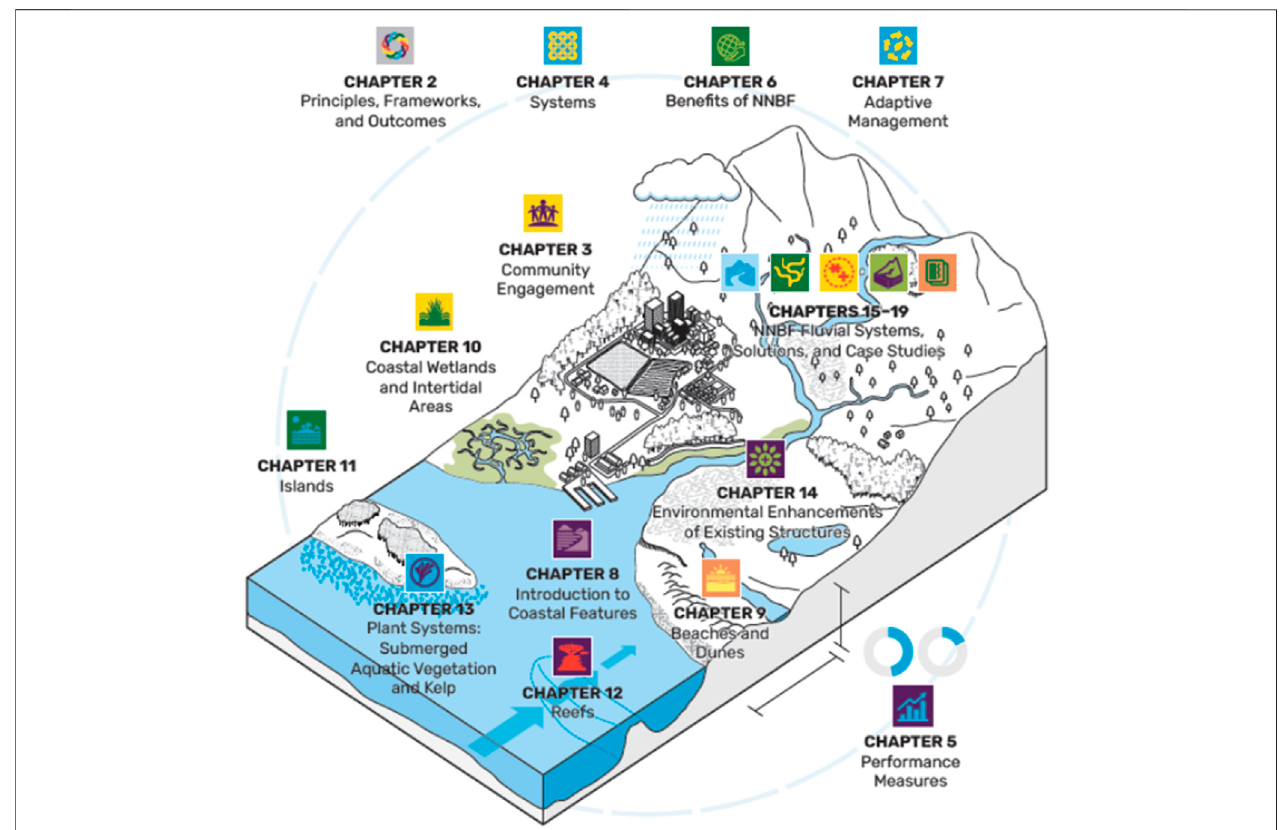
FIGURE 1 | Contents and concepts of NNBF guidelines within a systems context (Bridges et al., 2021).